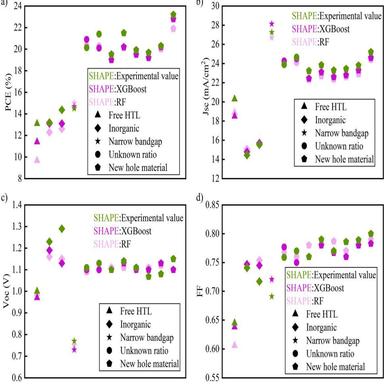
The prediction of photovoltaic prediction models for five perovskite devices. Shapes represent different device types, namely, perovskite cells without hole transport layer, inorganic perovskite cells, narrow-bandgap perovskite cells, unknown elemental ratios of perovskite cells, and perovskite cells with new hole material. The colours represent the different values, which are the experimental values in the publication, the predicted values based on the XGBoost and the RF algorithm model. a) prediction stat